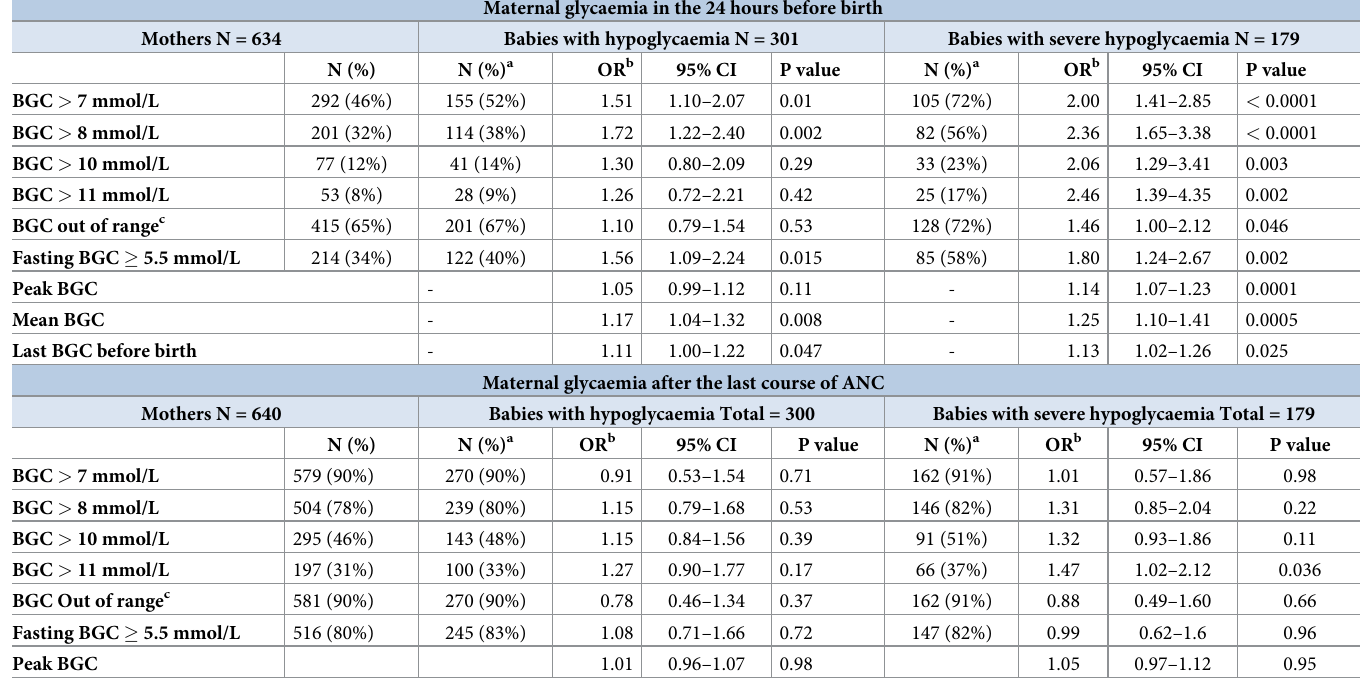
Table 4. Association between neonatal hypoglycaemia and measures of maternal glycaemic control within 24 hours of birth and after the last course of antenatal corticosteroids. Maternal glycaemia in the 24 hours before birth Mothers N = 634 Babies with hypoglycaemia N = 301 Babies with severe hypoglycaemia N =